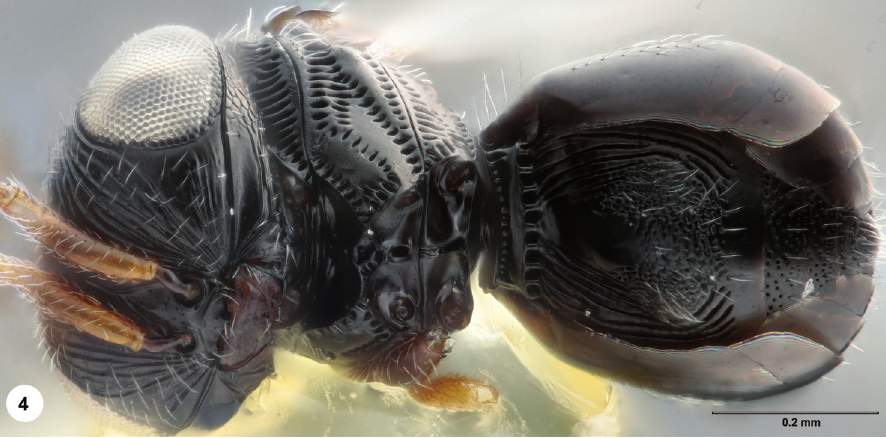
Figure 4. Psix saccharicola (FSCA 00094886), head, mesosoma, metasoma, ventral